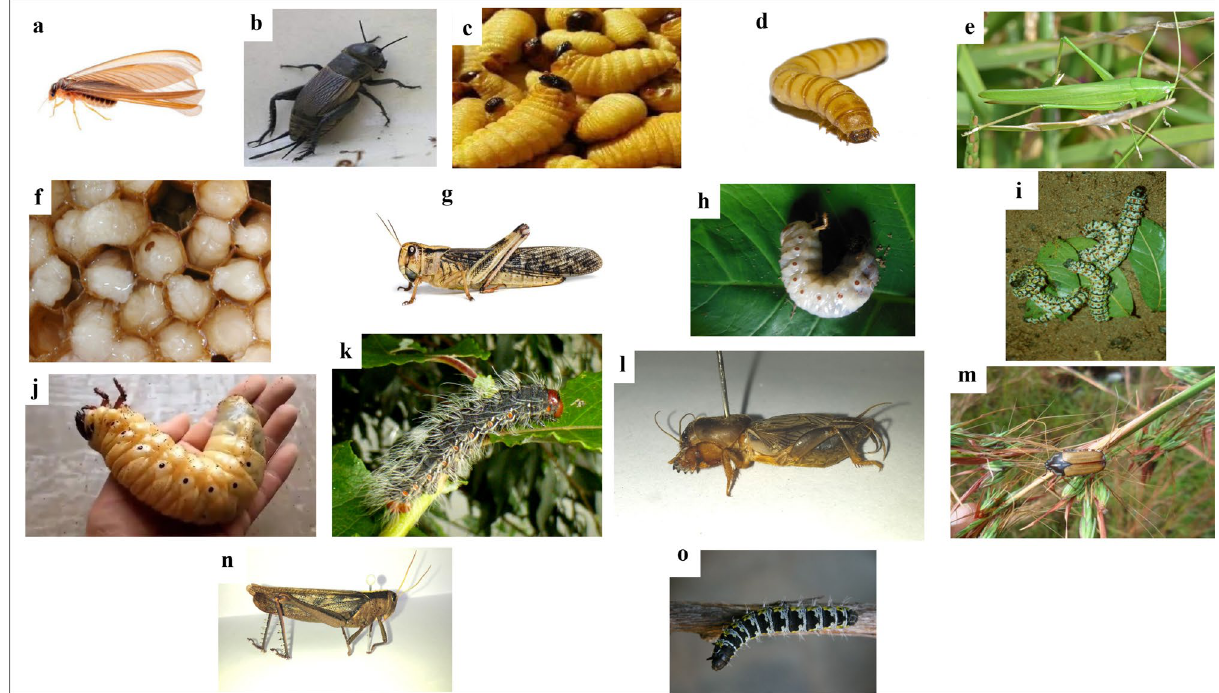
Figure 2. ( a ) Macrotermes subhyalinus (Termite); ( b ) Acheta domesticus (House cricket); ( c ) Rhyncophorus phoenicis larvae (Palm weevil larvae); ( d ) Alphitobius diaperinus larvae (Beetle); ( e ) Ruspolia differens (Grasshopper); ( f ) Apis mellifera larvae (Honey bee); ( g ) Locusta migratoria (Migratory locust); ( h ) Rhynchophorus ferrugineus larvae (Red palm weevil); ( i ) Imbrasia oyemensis (Caterpillar); ( j ) Oryctes monoceros larvae (Rhinoceros beetle); ( k ) Imbrasia epimethea (Caterpillar); ( l ) Gryllotalpa Africana (Mole cricket); ( m ) Gnathocera trivittata (Nsike); ( n ) Nomadacris septemfasciata (Red locust; ( o ) Cirina forda (Misigi). (Images mixed using Microsoft PowerPoint for Mac 16.29.1 https:// www. micro soft.